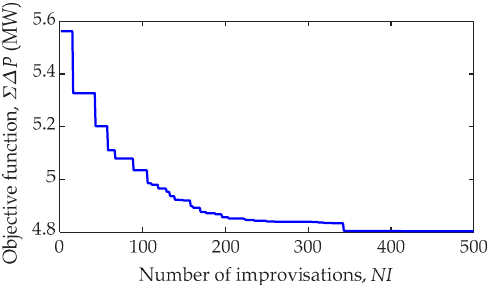
Figure 9. Convergence curve of optimal settings of UFRs for low inertia—winter season.